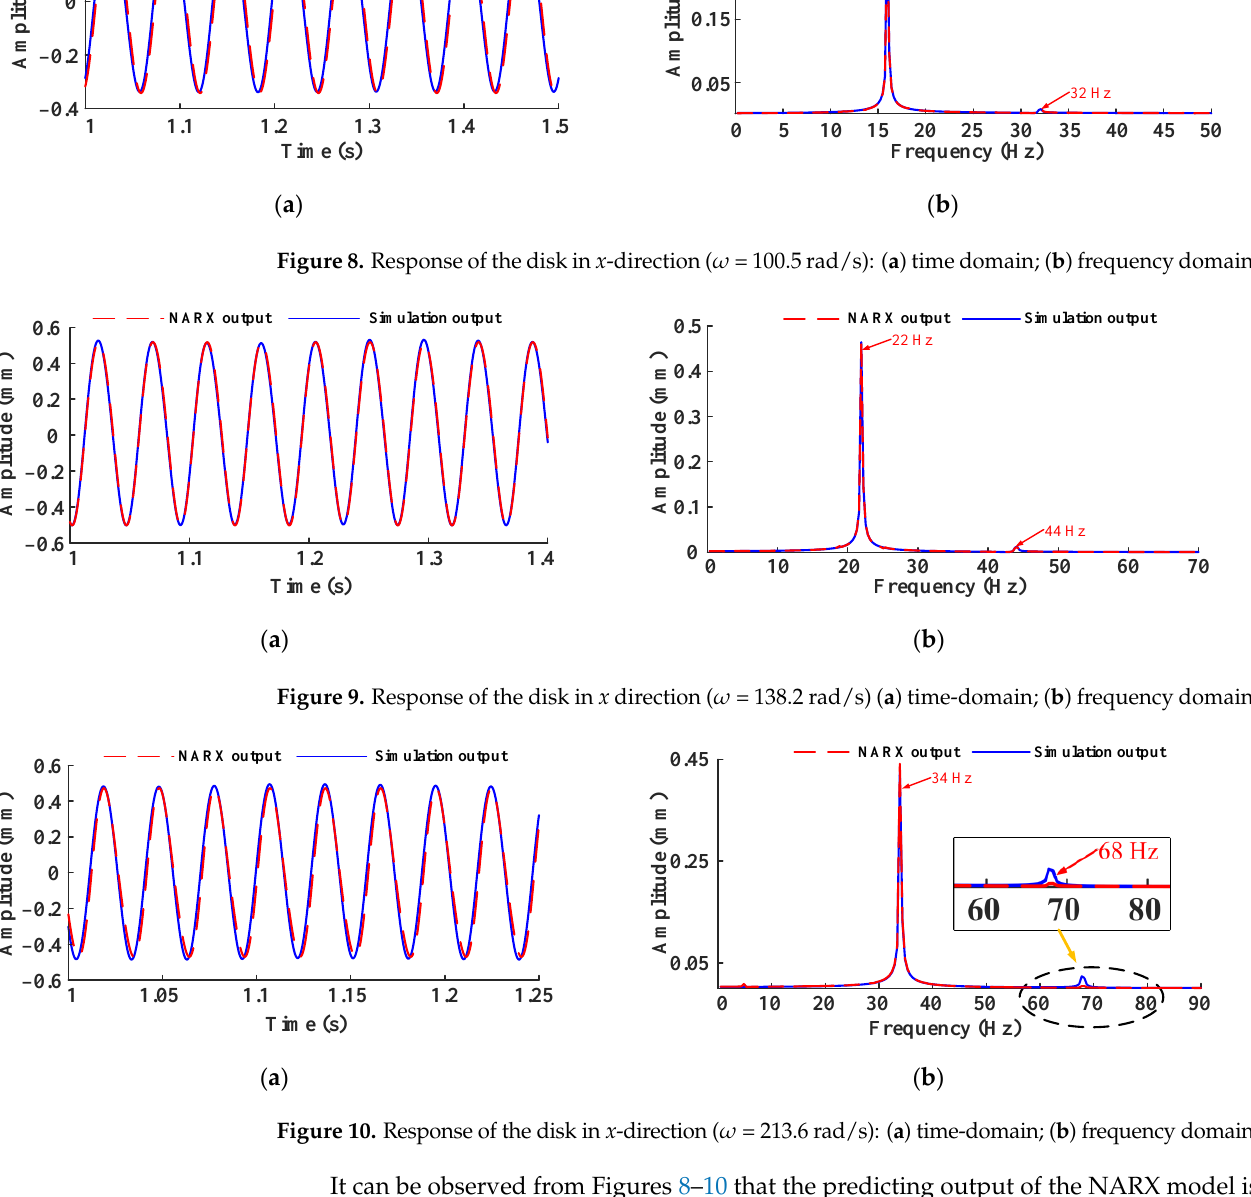
213.6 rad/s ω ): ( a ) time-domain; ( b ) frequency do-